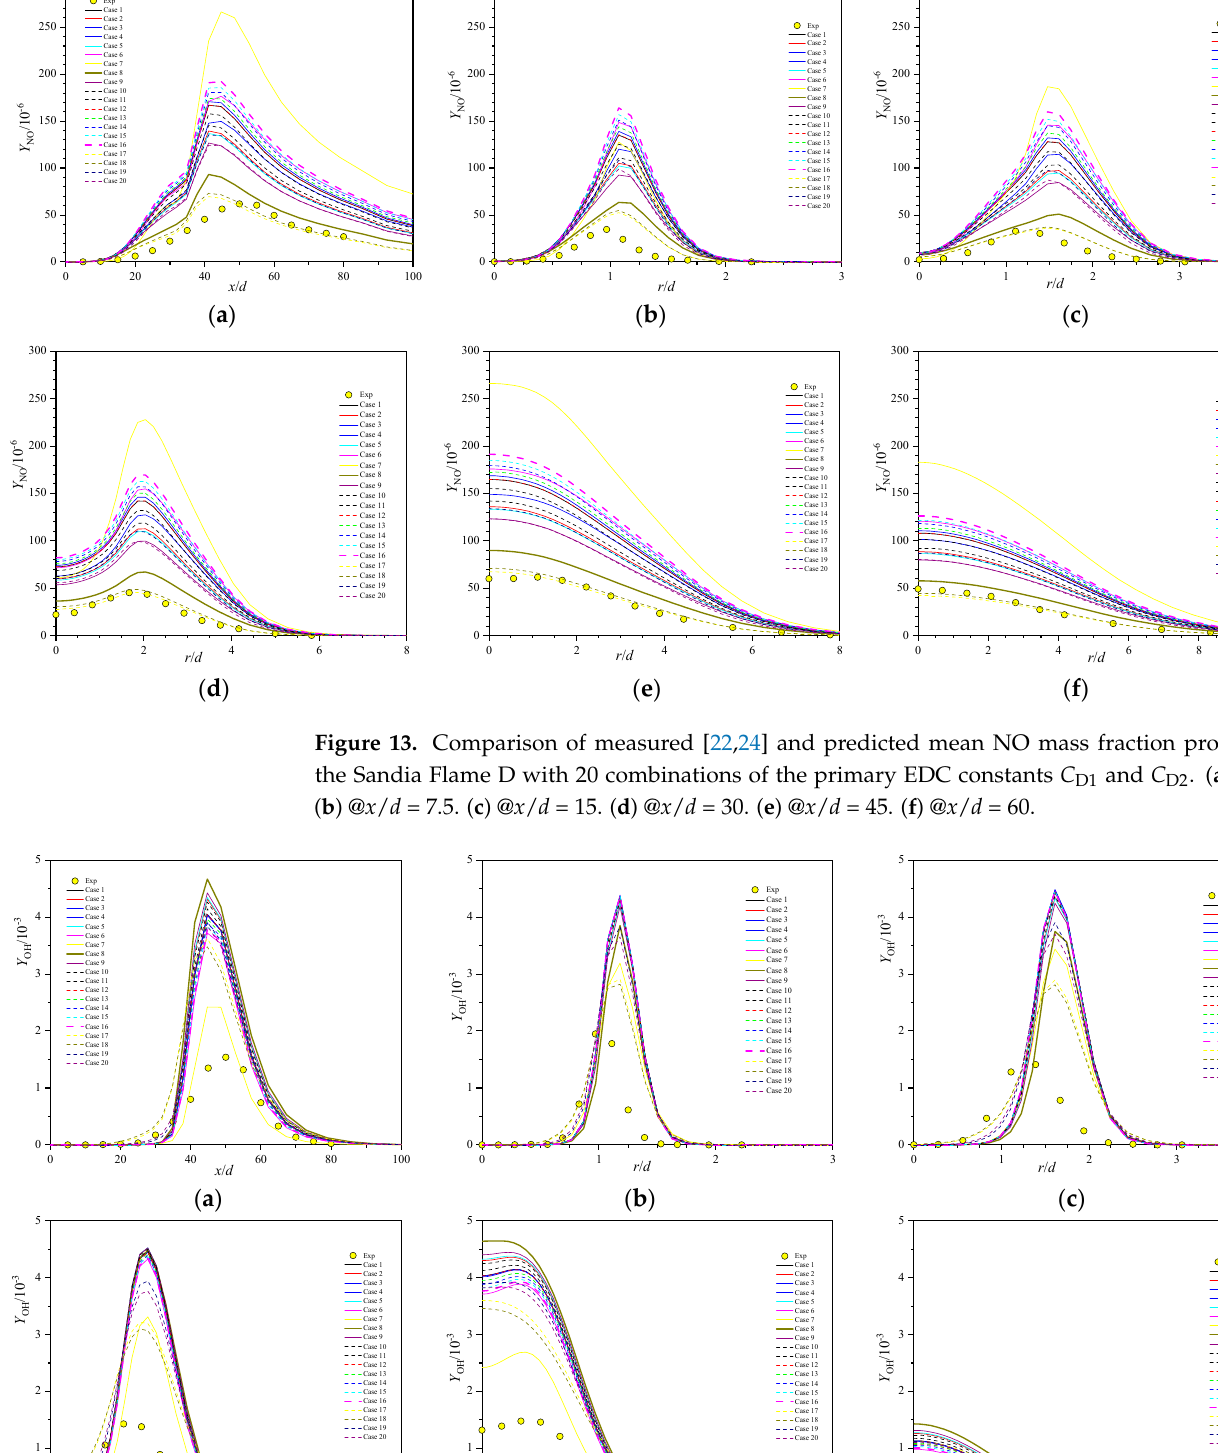
( e ) Figure 12. Comparison of measured [22,24] and predicted mean H 2 mass fraction profiles for the Sandia Flame D with 20 combinations of the primary EDC constants 𝐶 (cid:2888)(cid:2869) and 𝐶 (cid:2888)(cid:2870) . ( a ) @axis. ( b ) @ x / d = 7.5. ( c ) @ x / d = 15. ( d ) @ x / d = 30. ( e ) @ x / d = 45. In Figure 13, the mean NO mass fractions along the axis and the radii of cases 8, 17, and 18 are found to agree well with the experiments. However, the EDC constants of cases 17 and 18 violate the criteria for the proposed EDC constants [21]. The results of the other cases are significantly over-predicted, especially at locations around the peak temperature where the mixtures burn intensely, and large deviations among the cases are found for the mean NO mass fraction profiles. The results [38] of Sandia Flame D with the original EDC constants, which is case 4 in this work, also show that the results of the mean NO mass fractions are significantly over-predicted. Therefore, the EDC constant combinations of case 8 are suggested for the modeling of Sandia flame D.